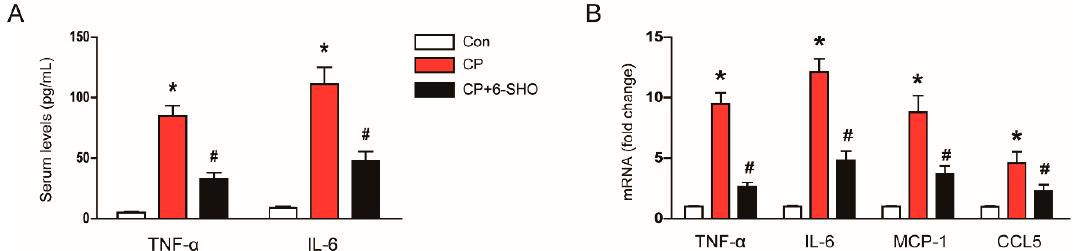
Figure 8. Effect of 6-shogaol on production of cytokines and chemokines in cisplatin-treated mice. ( A ) Serum levels of tumor necrosis factor- α (TNF- α ) and interleukin-6 (IL-6). ( B ) Relative mRNA levels of TNF- α , IL-6, monocyte chemoattractant protein-1 (MCP-1), and C-C motif chemokine ligand 5 (CCL5). GAPDH was chosen as an internal control. n = 8 per group of mice. * p < 0.05 versus Con. # p < 0.05 versus CP.